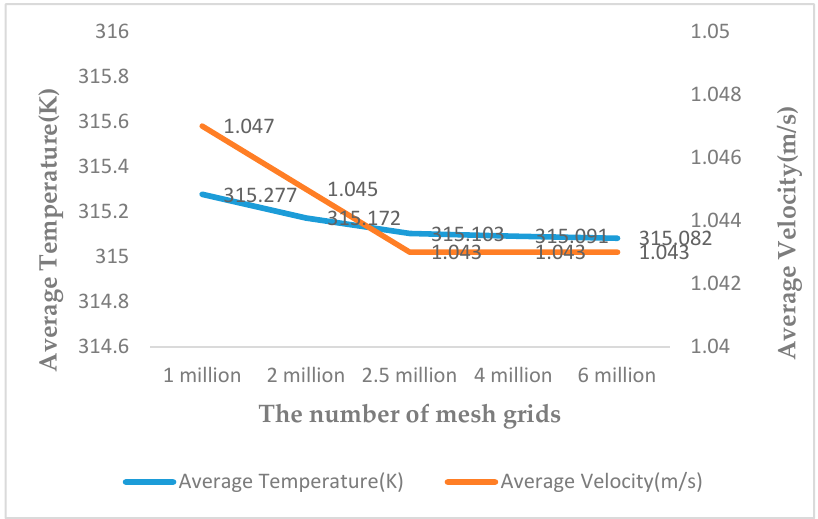
Figure 3. (a) Temperature contours and velocity contours under 1 million grids; (b) Temperature contours and velocity contours under 2 million grids; (c) Temperature contours and velocity contours under 2.5 million grids; (d) Temperature contours and velocity contours under 4 million grids; (e) Temperature contours and velocity contours under 6 million grids.